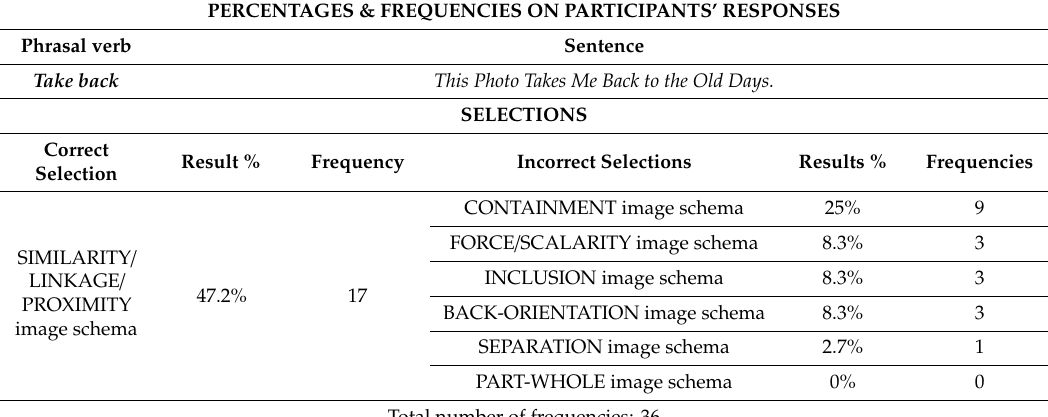
Table 11. Frequencies for take back